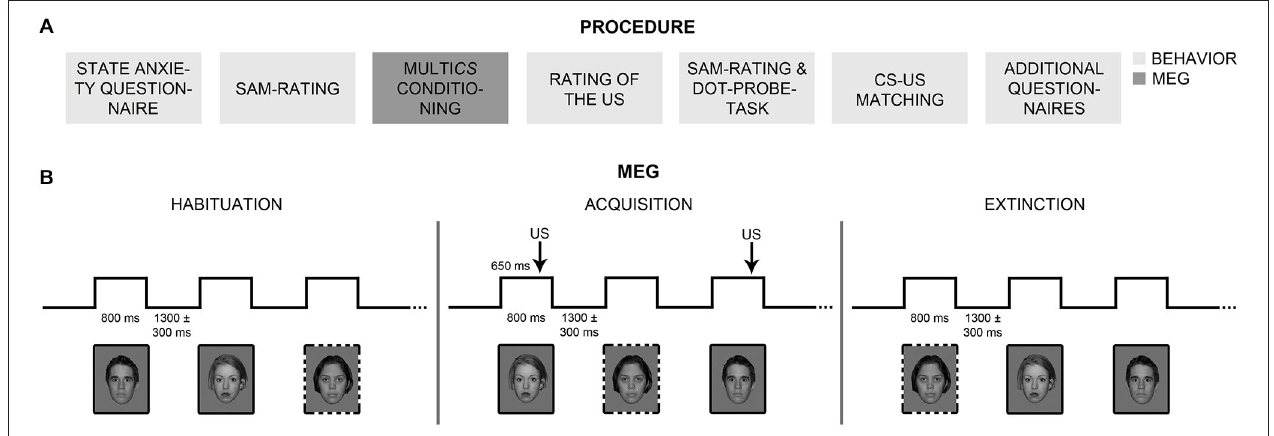
i.e., habituation, acquisition, and extinction. During habituation and extinction, the conditioned stimuli (CSs, 104 different neutral faces) were shown three times each in random order and without US presentation. During acquisition, half of the CSs were paired three times with the US (CS+; solid frames), while the other half remained unpaired (CS − ; dotted